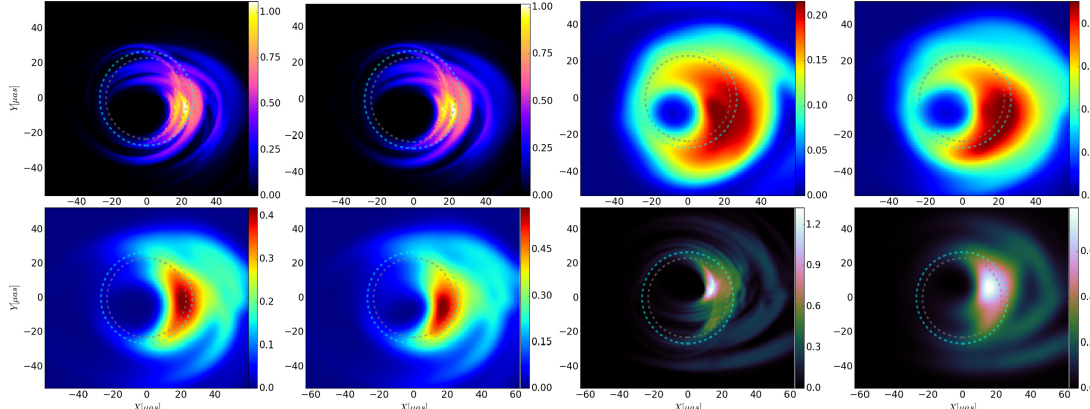
Figure 4. Black hole shadow image plane intensity plots for the Galactic center black hole Sgr A* as calculated from a model geometry consisting of a disk and jet around a black hole. The series demonstrates the richness in the parameter space that can be considered, such as (i) a single observer comparison to the parameter space of [45]; (ii) instead, eight snapshots time-averaged; (iii) applying an inclination of i = 45 ◦ , and a fixed ion-to-electron temperature (as in Moscibrodzka et al. (2009); (iv) applying another default time instead (little difference); (v) applying different jet and gas temperatures (no isothermal jet); (vi) applying an isothermal jet; (vii) a best-fit for all